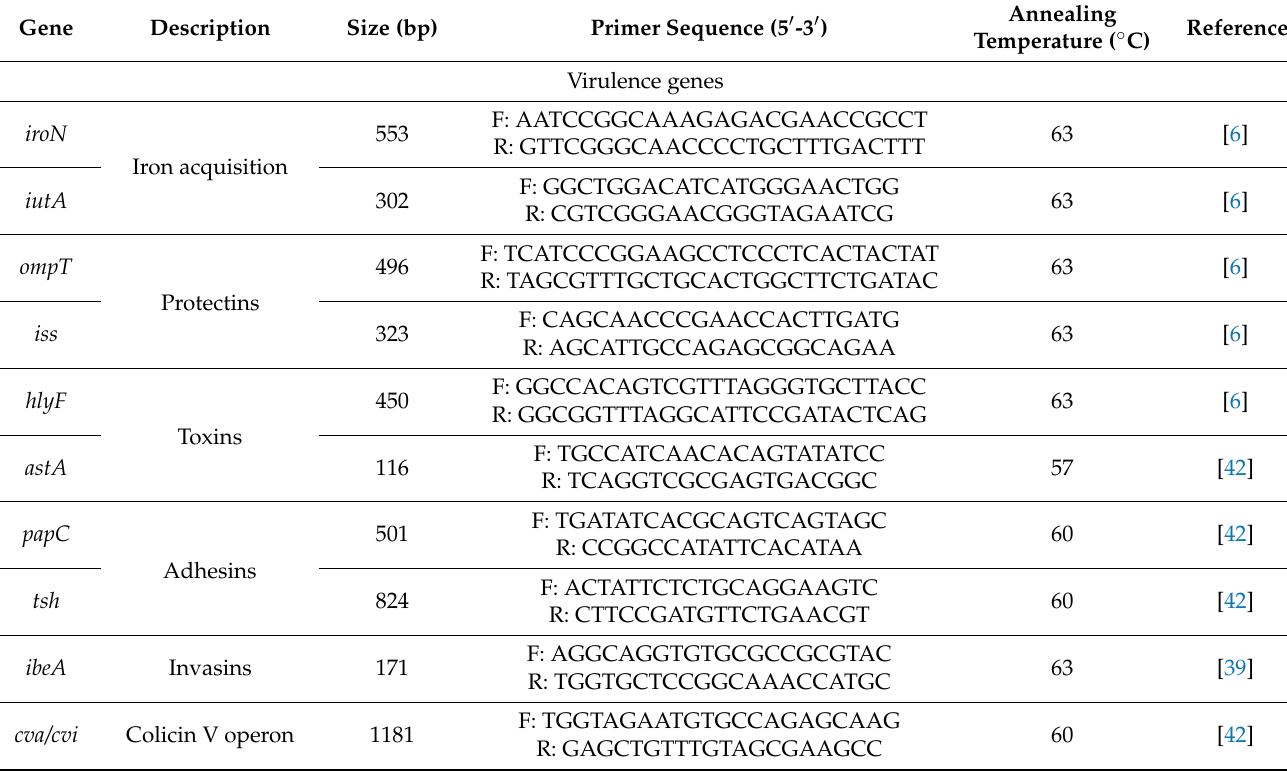
Table 1. Primer sequences and annealing temperatures used for the PCR analysis of virulence- associated